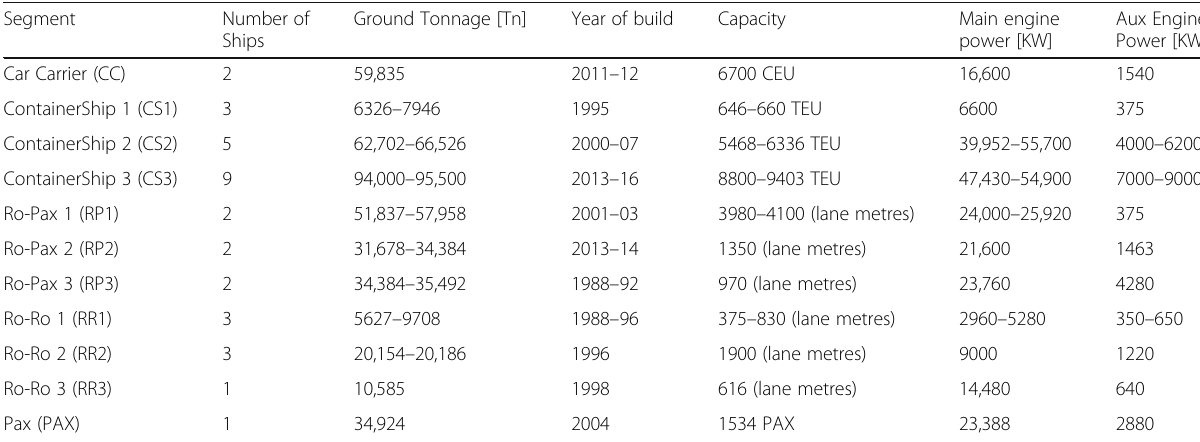
Table 1 Some of the characteristics of the different ship types analysed, including the number of ships of that type, ground tonnage, year of build, capacity (in the corresponding units) and main and aux engine power